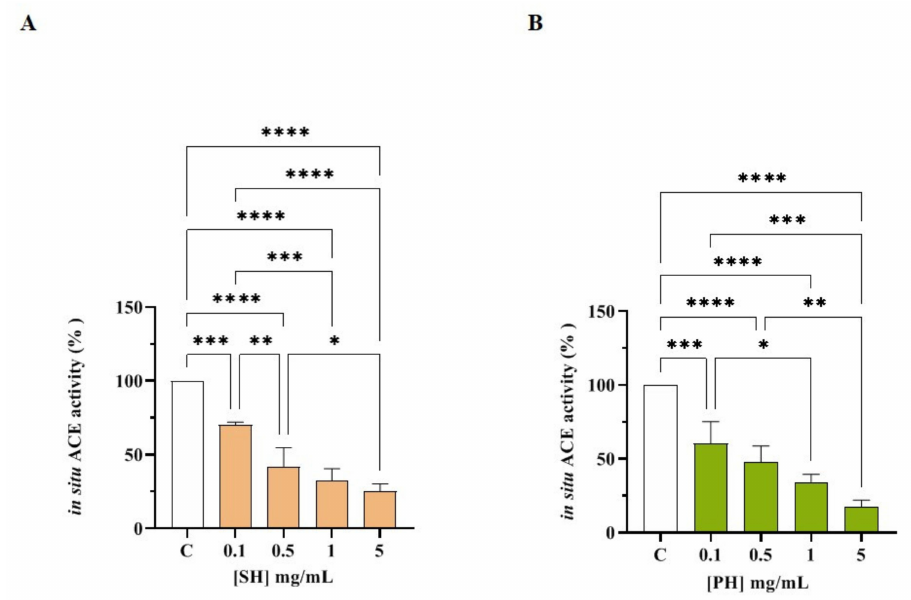
Figure 6. ACE inhibitory effects of SH ( A ) and PH ( B ) hydrolysates in cell-based conditions. Bars represent the SD of three independent experiments in triplicate. **** p < 0.0001, *** p < 0.001, ** p < 0.01, * p < 0.05 versus control sample (C), non-significant (ns) is not